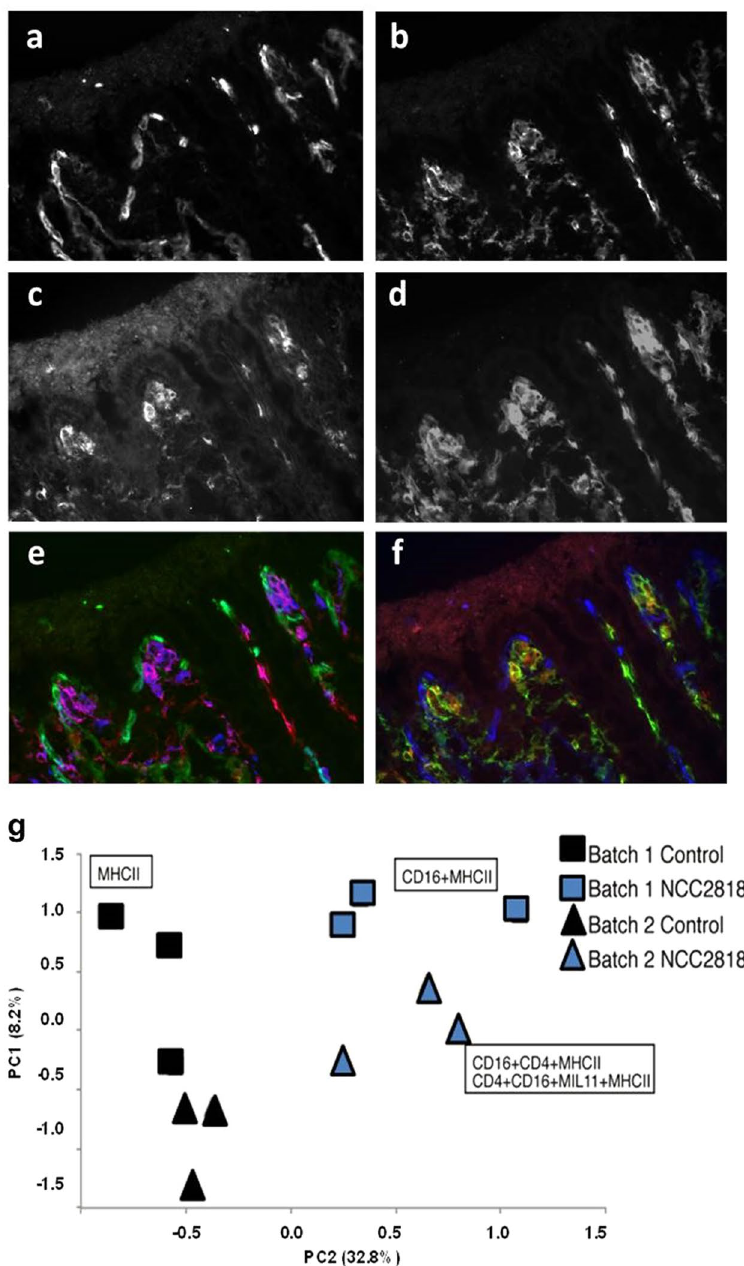
Figure 4. Reduced inter-batch variation in mucosal antigen expression in animals supplemented with B.lactis NCC1818. Representational images of CD4 ( a ), CD16 (bone-marrow-derived APC) ( b ), MIL11 (intestinal epithelium) ( c ) and MHCIIDR ( d ) staining in colonic tissue of a control piglet. Representational image of co-staining with CD16 (red), MIL11 (green) and MHCIIDR (blue) ( e ) and co-staining with CD4 (red), CD16 (green) and MIL11 (blue) ( f ). Co-localisation of MHC class II with, endothelial cells (MIL11) and CD4 + T-cells determined by principal component analysis. Principal component 1 was not associated with either treatment (n = 6) or batch (n = 6). Principal components 2 and 3 for each piglet, identified by treatment (colour) and batch